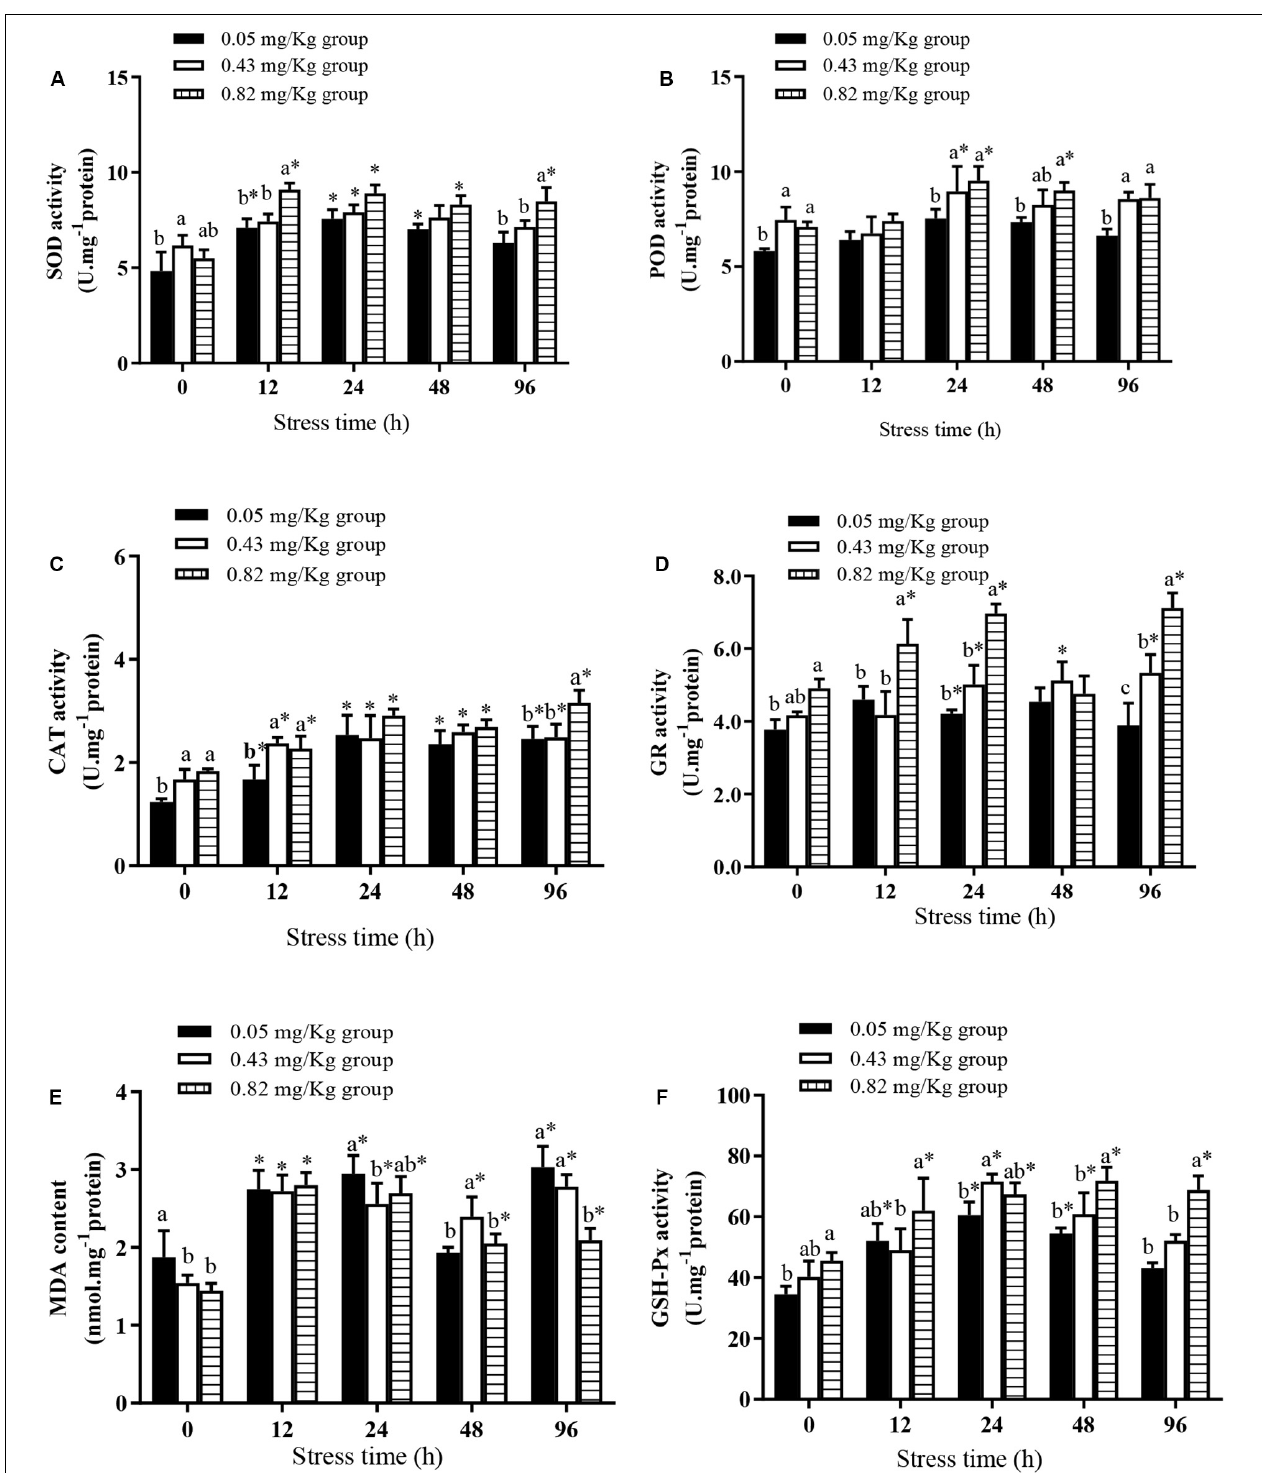
FIGURE 1 | Effects of dietary supplementation with Se-cultured Potamogeton maackianus powder on antioxidant capacity of Chinese mitten crab ( Eriocheir sinensis ) and its response under Cu 2 + stress ( N ≥ 9). This study is divided into three experimental groups, adding 0.05, 0.43, and 0.82 mg/kg Se to the feed. After 60 days of rearing experiment, hepatopancreas tissues of 10 fish were taken for determination of SOD (A) , POD (B) , CAT (C) , GR (D) , MDA (E) , and GSH-Px (F) levels/activities. At 12, 24, 48, and 96 h of Cu 2 + stress, nine crabs in each experimental group were randomly selected, and their hepatopancreases were taken for determination of SOD, POD, CAT, GR, MDA, and GSH-Px levels/activities. ∗ indicates significant differences between values obtained before and after injection (paired-samples t test; P < 0.05). Different lowercase letters show significant differences among different treatments at each sampling point (Duncan’s multiple range test; P < 0.05).